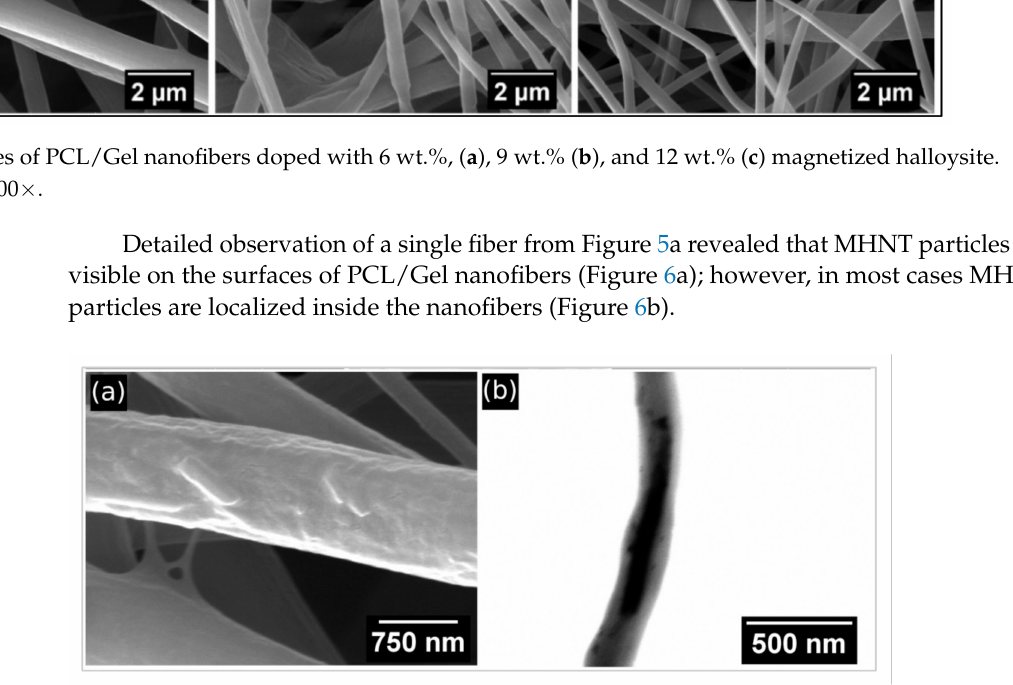
Figure 6. ( a ) Detailed SEM image of PCL/Gel nanofibers doped with 6 wt.% MHNT, with visible MHNT particles on the surface (magnification = 75,000 × ). ( b ) STEM image (bright mode) of MHNT particles inside the PCL/Gel nanofibers (magnification = 150,000 ×